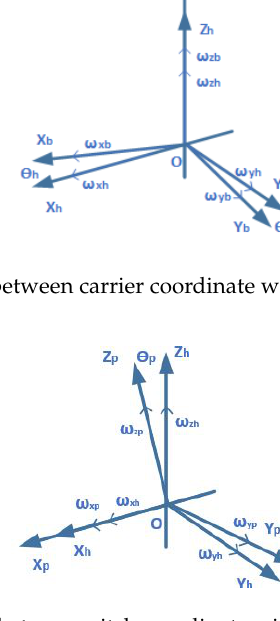
Figure 3. Relation between pitch coordinate with heading